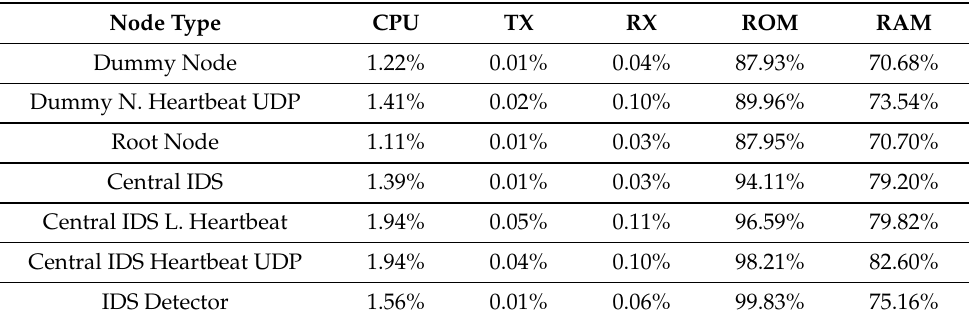
Table 2. Node type metrics table. TX: transmission.